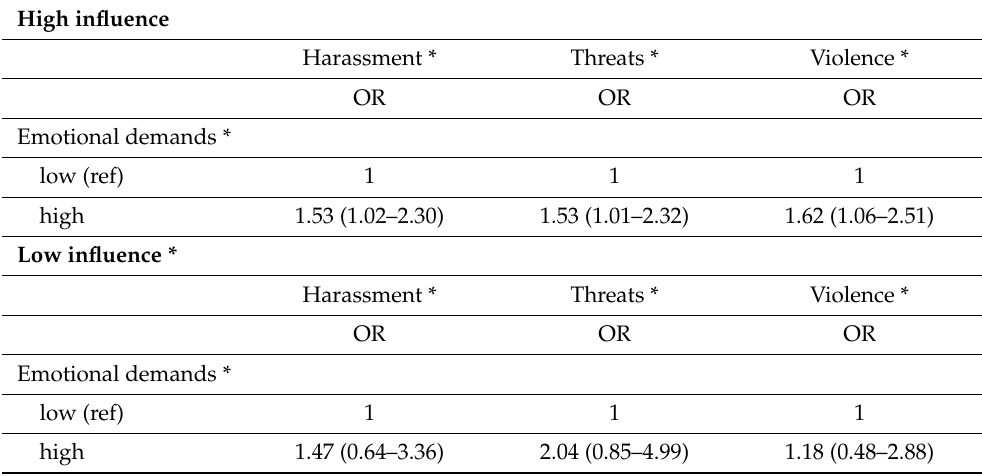
Table 5. Associations between emotional demands at work and harassment, threats and violence stratified by level of influence over own